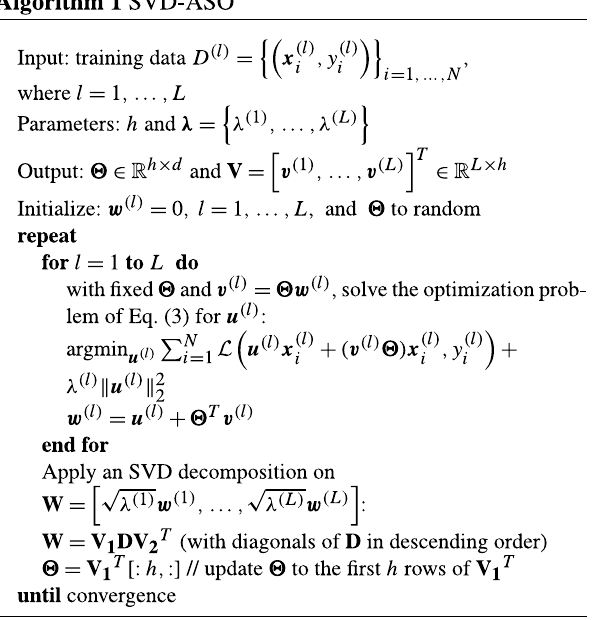
d of the full space is decomposed into two R ∈ h of the low-dimensional one. The low- R ∈